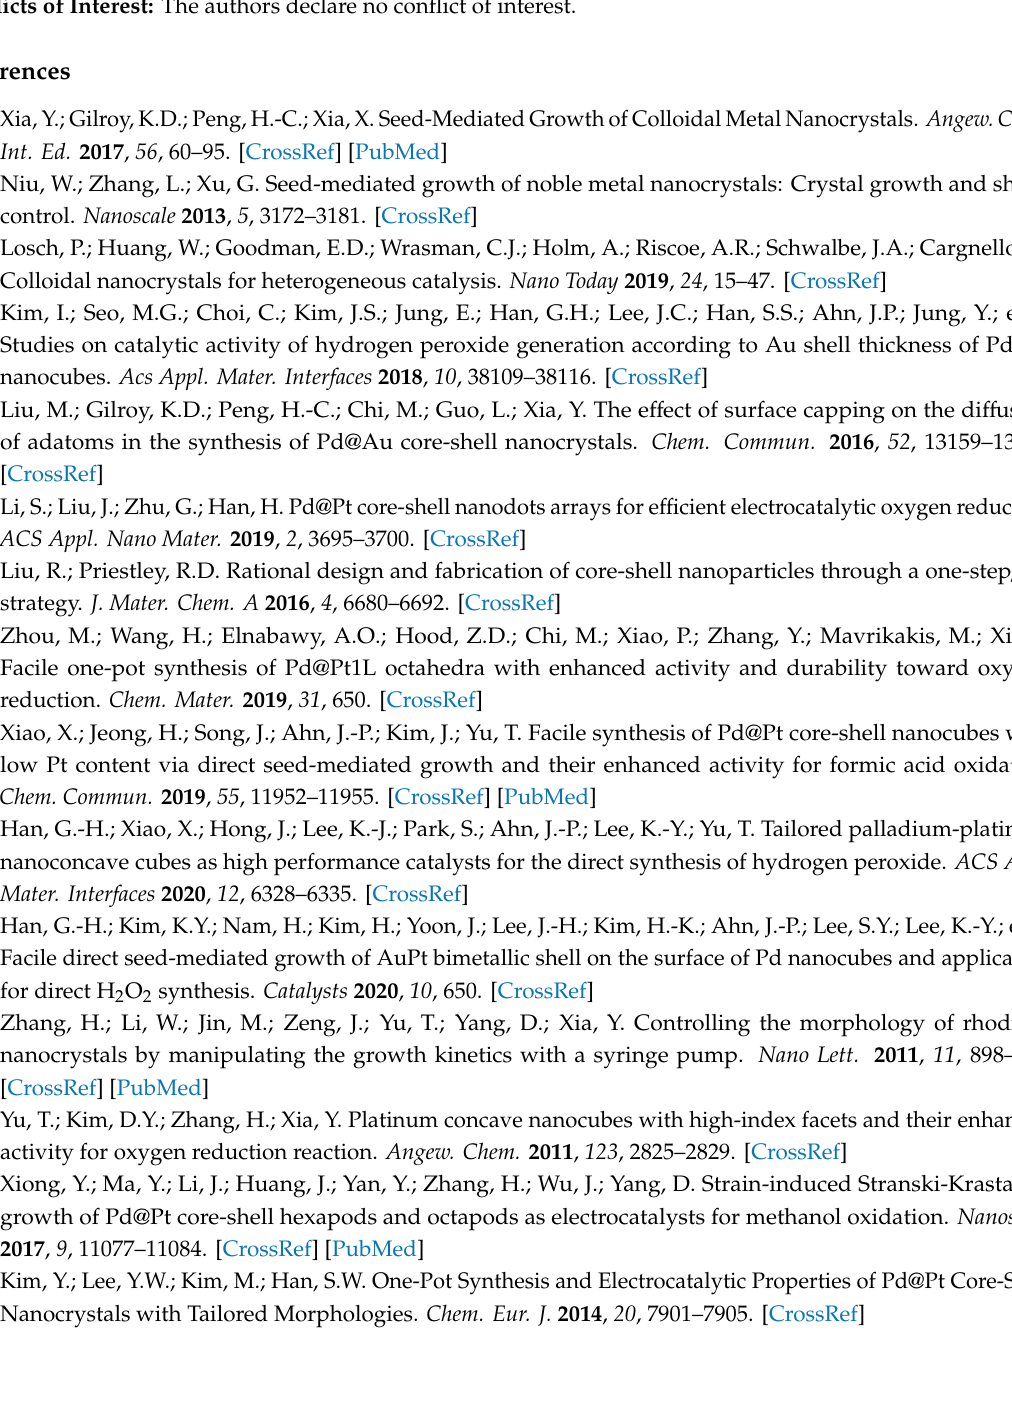
Table S1: ICP results of P-PdPt and F-PdPt. Figure S1: XRD patterns of P-PdPt, F-PdPt, and Pd nanocubes. Figure S2: HRTEM images of Pd@Pt core–shell nanocubes. Figure S3: EDX mapping images of PdPt 0.6 and PdPt 4.5 core–shell nanocubes. Figure S4: MOR of Pd / C. Figure S5: Cyclic voltammetry curves (based on the Pt loading) F-PdPt and